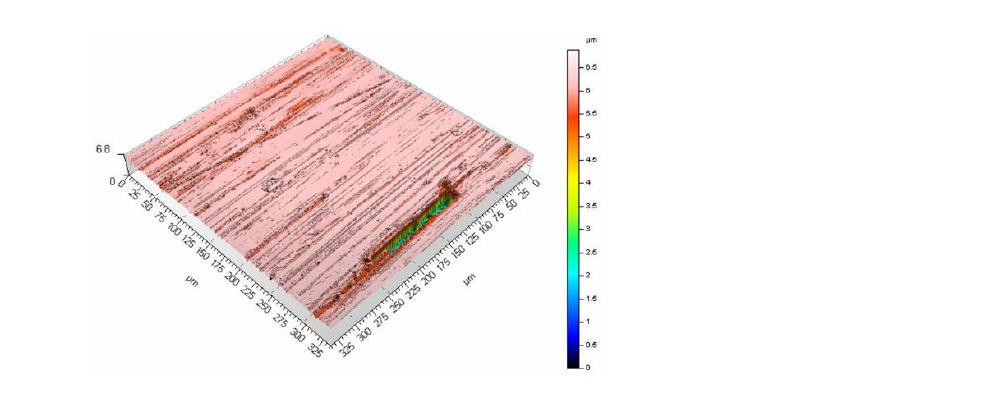
Figure 14. The surface morphology of a surface treated with emery paper no. 240 (mean roughness: Sa = 0.79 μ m).